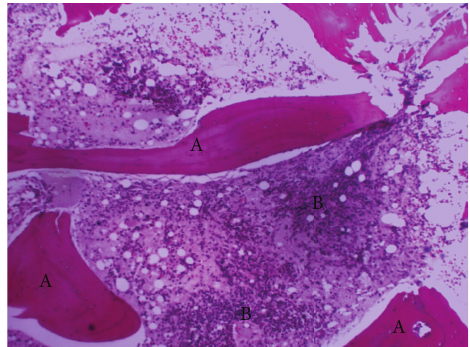
Figure 2: Bony trabeculae (letter A) with inflammatory cells (letter B) in bone marrow spaces.